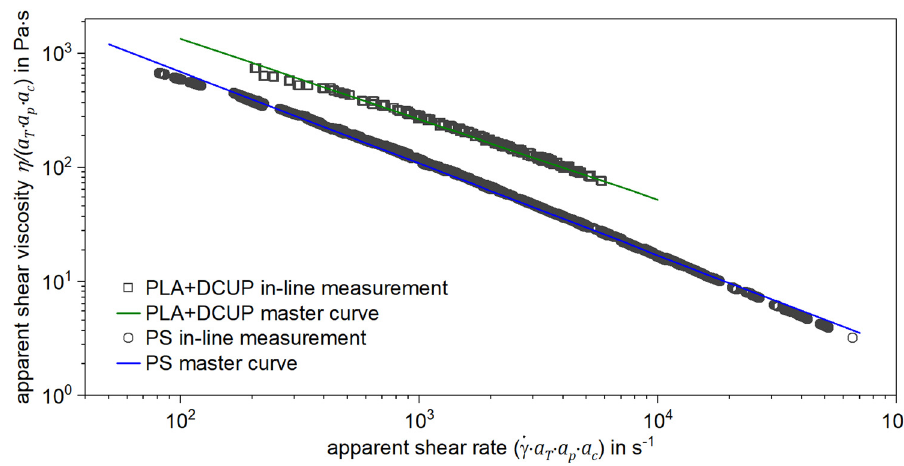
Figure 8: Prediction of master curves using the power - law model in combination with superposition principles for PS ( reference conditions: T = 260°C, p = 250 bar, and c = 0.25 wt% N ) , PLA + DCUP ( reference conditions: T 0 0 0 2 shifted apparent viscosity data from in - line measurements.